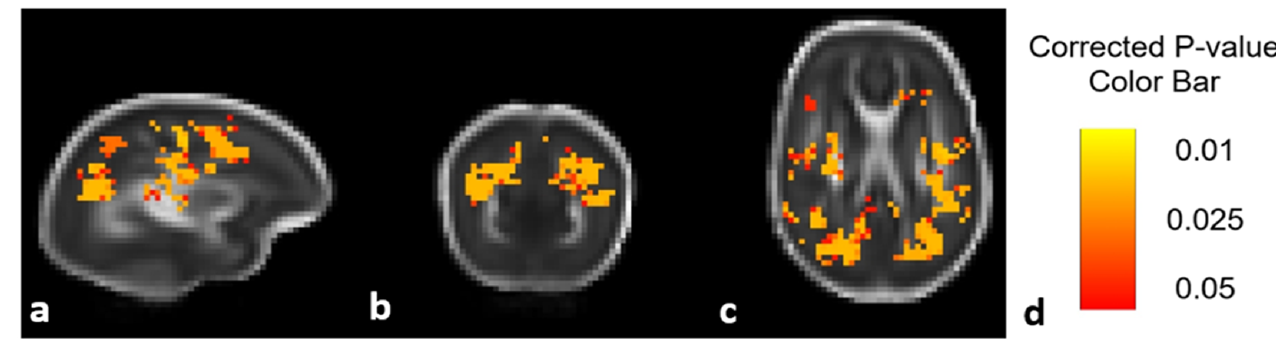
Figure 2. DTI comparison of Epo-treated and placebo-treated groups using ANTs analysis. MD differences seen in the sagittal ( a ), coronal ( b ), and axial ( c ) views. Highlighted areas signal regions in which the Epo treated group had significantly higher MD values compared to the placebo group prior to evaluation with multiple corrections. p -value color bar shown in ( d ).